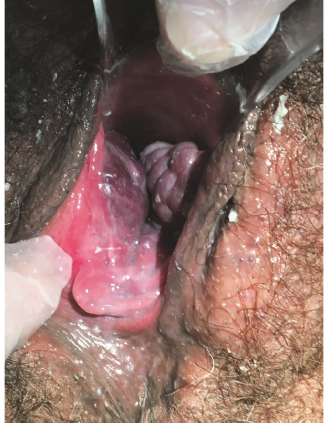
Figure 1: Vaginal varicosities protruding beyond hymenal ring.